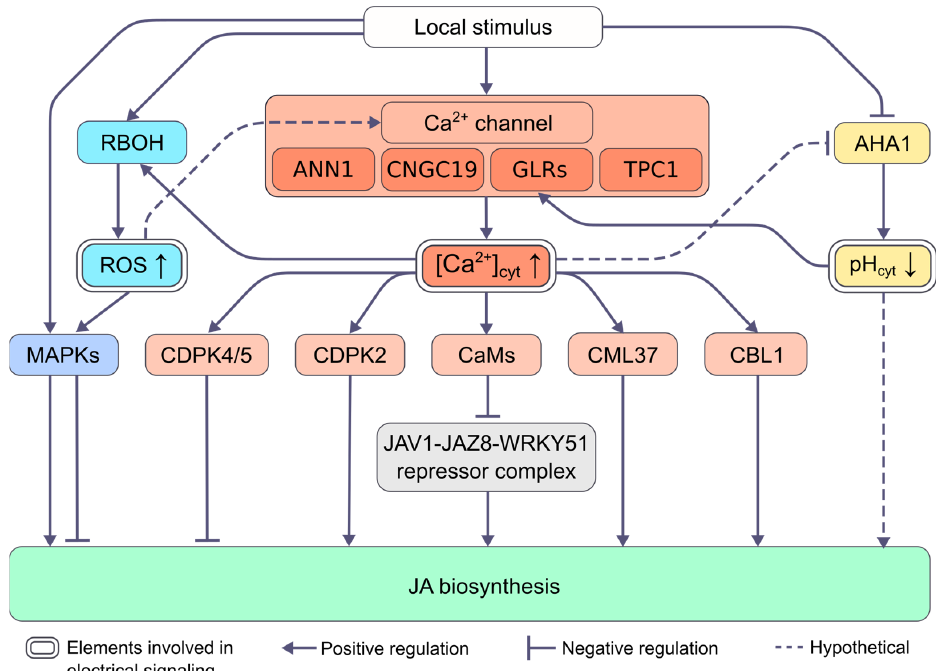
Figure 3. Model for regulation of stimulus-induced JA biosynthesis by electrical signals. Local stimulus causes the generation and propagation of electrical signals, which are accompanied by changes in pH, Ca 2+ and ROS levels, mediated by changes in the activity of H + -ATPase AHA1, Ca 2+ channels and NADPH oxidase RBOH, respectively. Altered pH, Ca 2+ and ROS levels induce changes in the activity of downstream responders that eventually regulate JA biosynthesis. Abbreviations: AHA1, H + -ATPase 1; ANN1, ANNEXIN 1; [Ca 2+ ] cyt , cytosolic Ca 2+ concentration; CaMs, calmodulins; CBL1, calcineurin B-like protein 1; CDPK, calcium-dependent protein kinase; CML37, calmodulin-like protein 37; CNGC19, CYCLIC NUCLEOTIDE GATED CHANNEL 19; GLRs, GLUTAMATE RECEPTOR-LIKE proteins; JA, jasmonate; JAV1, JASMONATE-ASSOCIATED VQ-MOTIF 1; JAZ8, JASMONATE ZIM-domain protein 8; MAPKs, mitogen-activated protein kinases; pH cyt , cytosolic pH; RBOH, respiratory burst oxidase homolog; ROS, reactive oxygen species; TPC 1, TWO-PORE CHANNEL